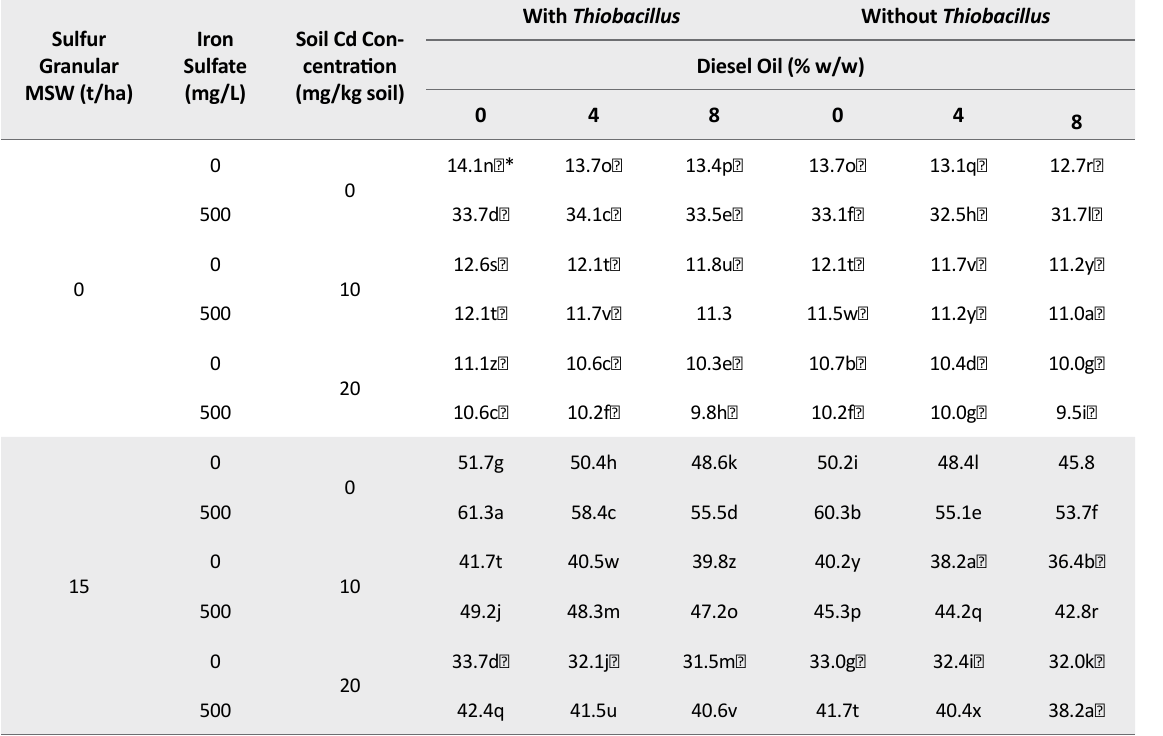
Table 6. Effect of treatments on plant Fe concentration (mg/kg) in the presence of thiobacillus bacteria